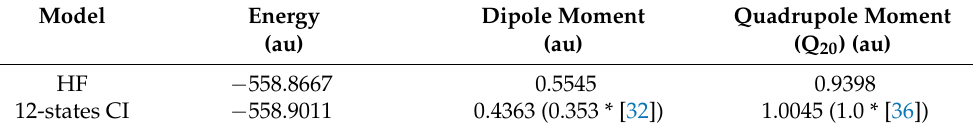
Table 1. Ground-state target properties for HF and 12-states CI